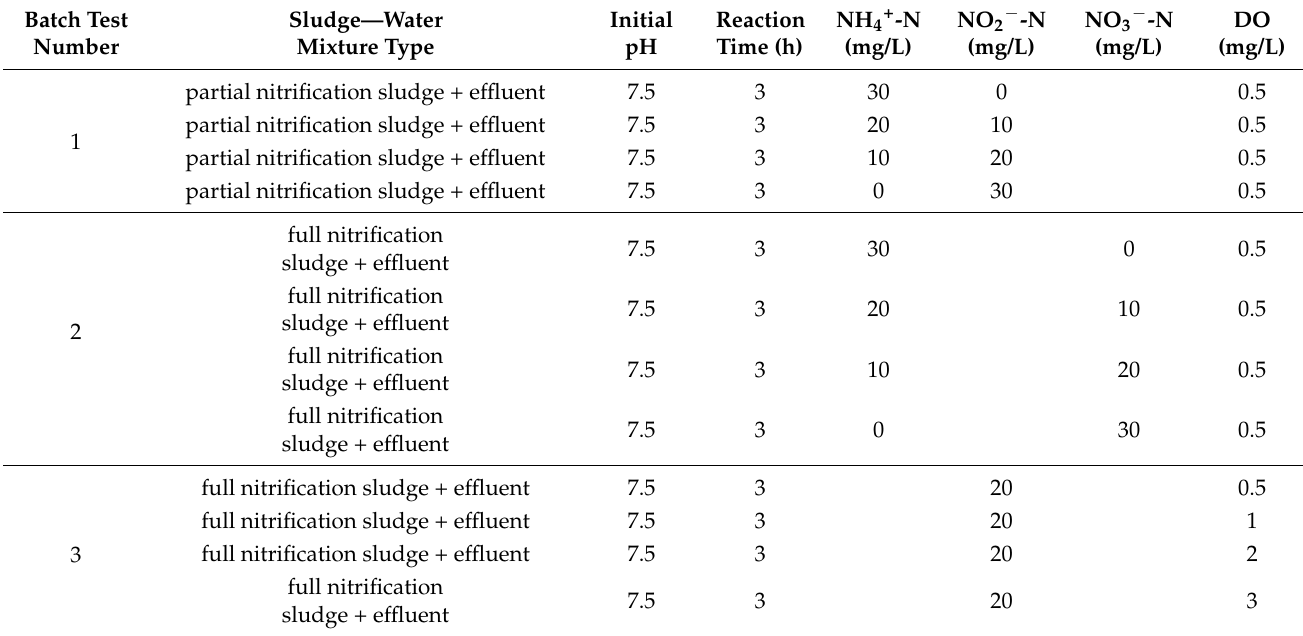
Table 2. Batch test